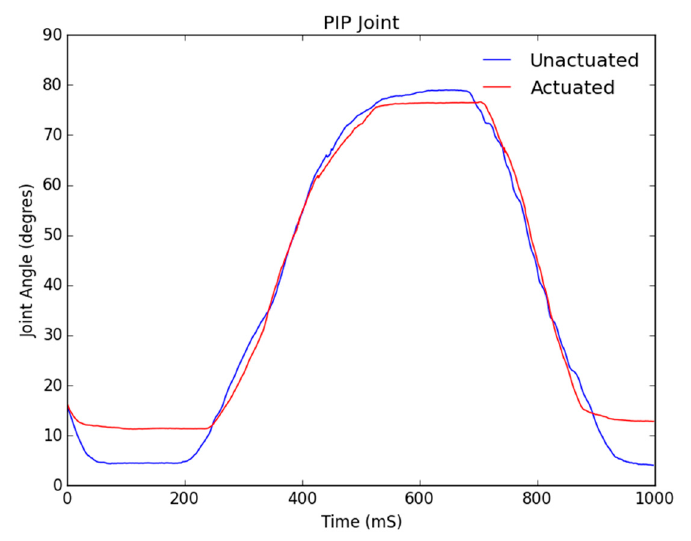
Figure 10. Motion analysis data for the proximal interphalangeal (PIP) joint.